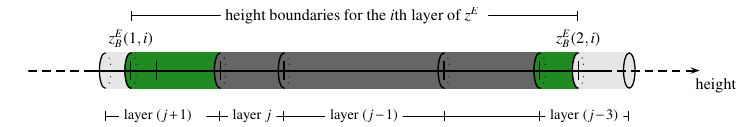
Figure 2. Interpolation factors for grid layers: green source grid layers are only partially overlapped by the i th destination layer.